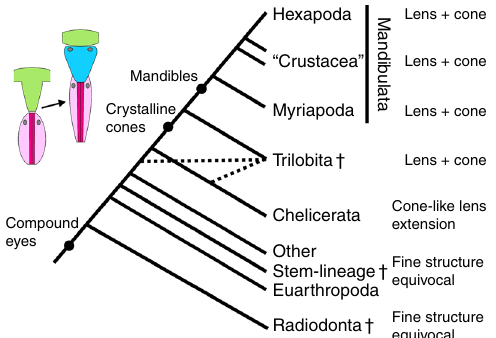
Fig. 4 Simpli fi ed cladogram of stem-lineage and crown-group of Euarthropoda (Mandibulata + Chelicerata). The evolutionary key characters of eye evolution are shown (combined from several articles 38 – 41 ). The ‘ other stem-lineage Euarthropoda ’ largely comprise the taxa that are sometimes considered as ‘ upper-stem Euarthropoda ’ 46 . Compound eyes with crystalline cones likely evolved in the lineage leading to Trilobita and Mandibulata comprising Myriapoda, Hexapoda, and paraphyletic crustaceans, rendering trilobites part of the mandibulate stem-lineage. Alternative hypotheses about the phylogenetic position of trilobites (stem lineage of Chelicerata 39 or stem- lineage of Euarthropoda 38 ) are indicated by dotted lines. If crystalline cones were already present in the compound eyes of Radiodonta 3 , then this character would not be informative with respect to the phylogenetic position of Trilobita. However, this changes to the opposite case if some of the other stem-lineage euarthropods that are more closely related to crown-group euarthropods possessed ommatidia with cuticular cones, as is likely the case for megacheirans